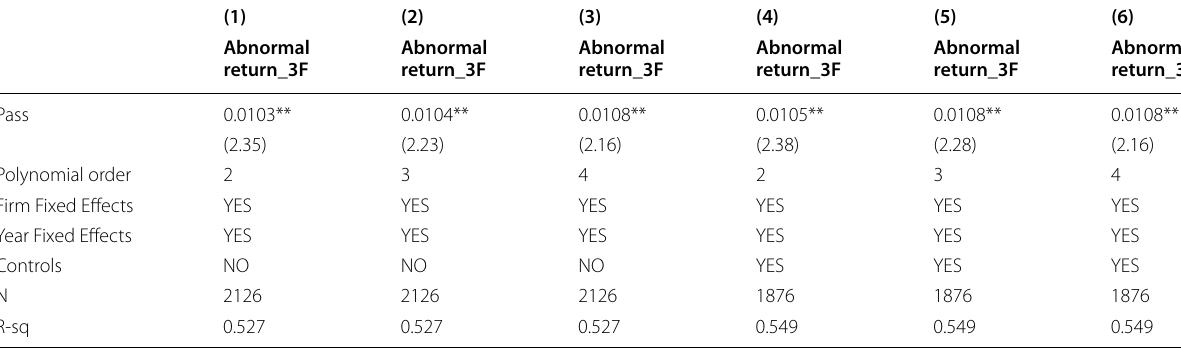
Table 8 Abnormal Returns RDD Results Robustness Check